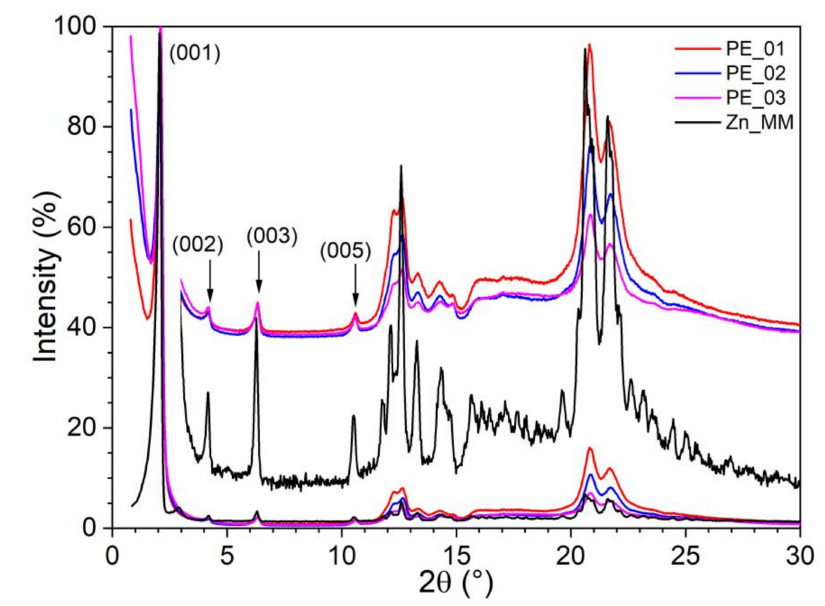
Figure 4. SAXS/WAXS patterns of pristine complex Zn_MM and paste electrodes